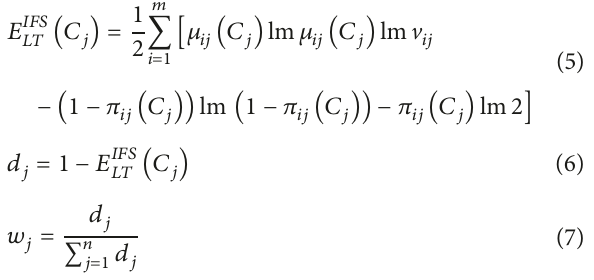
Figure 2: Trapezoidal fuzzy numbersfor systemand design require-